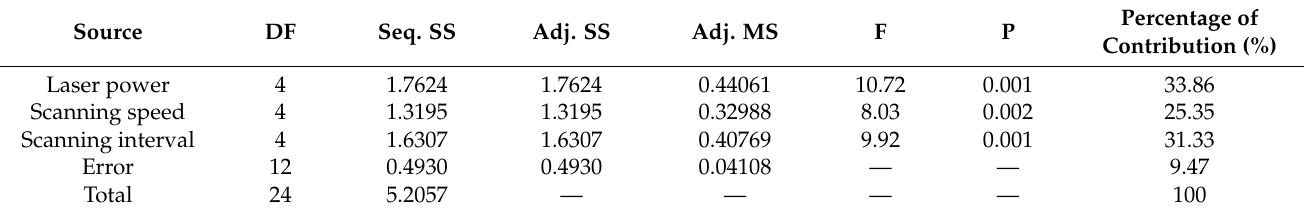
Table 6. Results acquired from ANOVA—relative